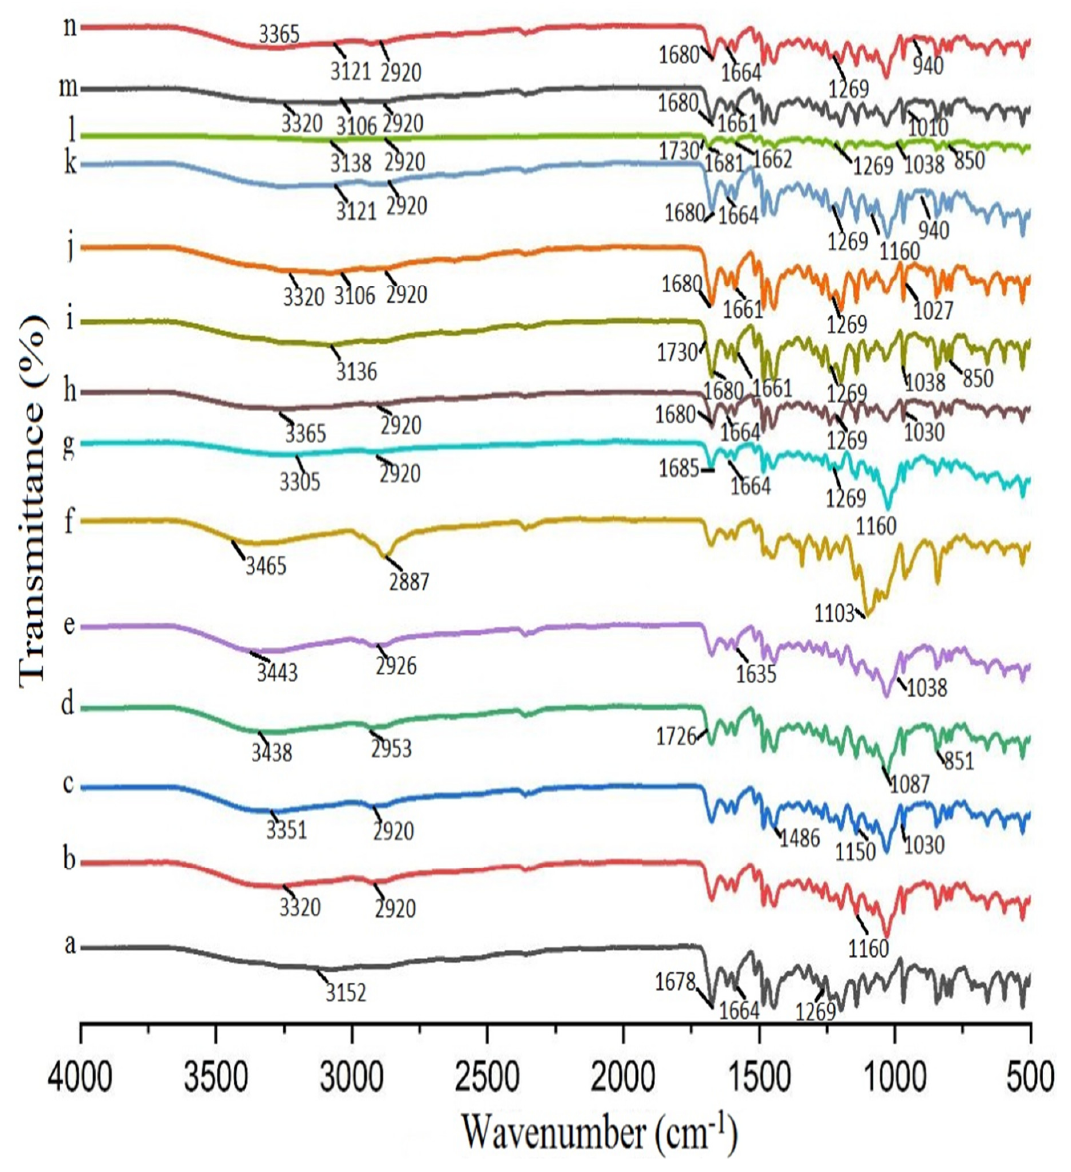
Figure 4. FTIR spectra of ( a ) DIF; ( b ) βCD; ( c ) HPβCD; ( d ) PVA; ( e ) CMC-Na; ( f ) PXM-188; ( g ) DIF/βCD